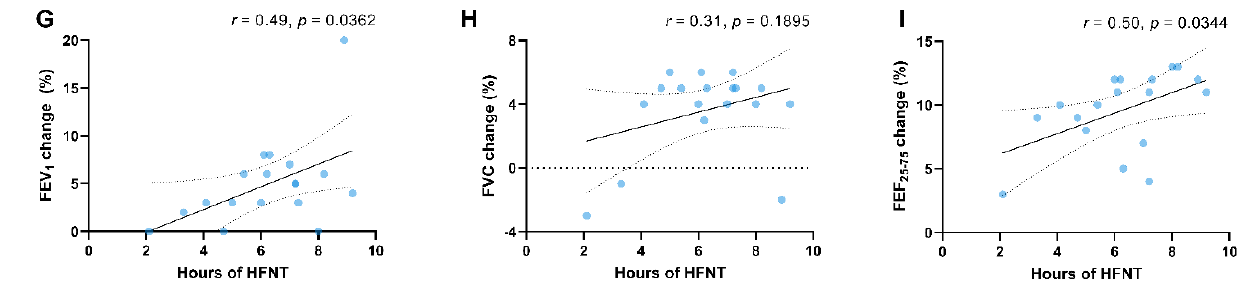
Figure 5. Scatter diagrams and regression lines (95% CI) on correlations between the amount of HFNT hours per day and changes in exacerbations ( A ) and hospitalizations ( B ) mMRC dyspnea scale ( C ), difficulty of expectoration (VAS) ( D ), SGRQ total score ( E ) and SpO 2 at rest ( F ) FEV 1 % ( G ), FVC% ( H ), and FEF 25–75 % ( I ). r = Pearson coefficient, ρ = Spearman coefficient. Abbreviations: HFNT, high-flow nasal therapy; mMRC, modified medical research council; VAS, visual analog scale; SGRQ, Saint George Respiratory Questionnaire; SpO 2 , peripheral blood oxygen saturation; FEV 1 , forced expiratory volume in the first second; FVC, forced vital capacity; FEF 25–75 , forced expiratory flow between 25% and 75% of FVC.